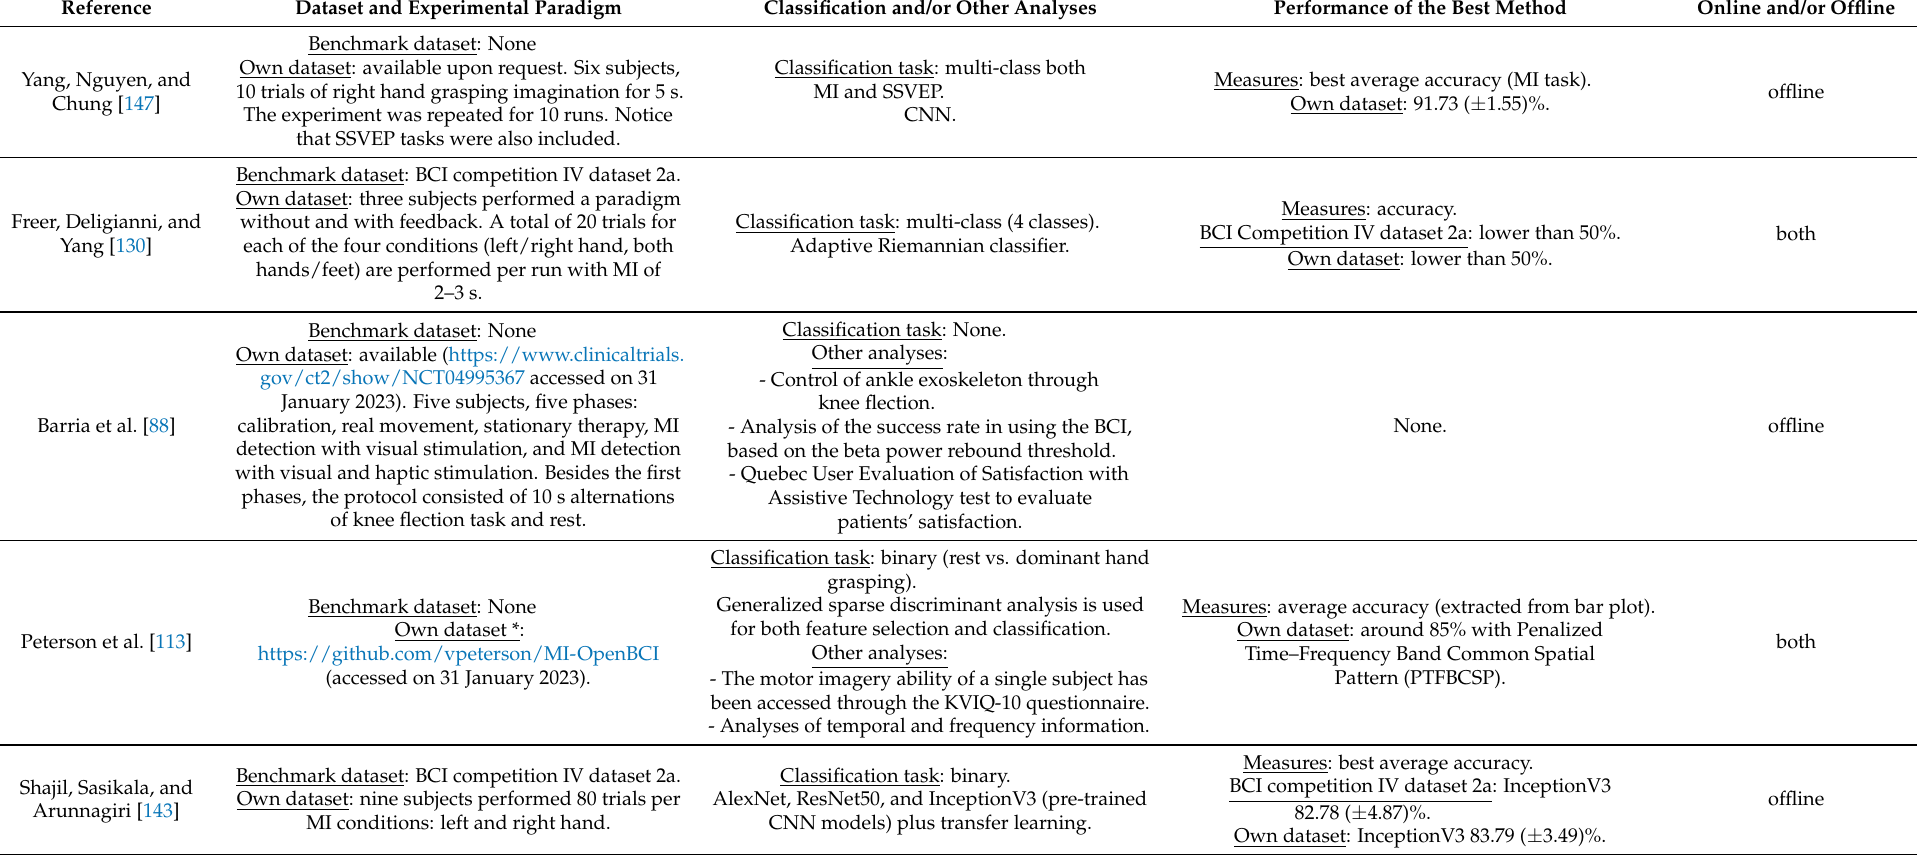
Classification task: binary. AlexNet, ResNet50, and InceptionV3 (pre-trained CNN models) plus transfer learning.